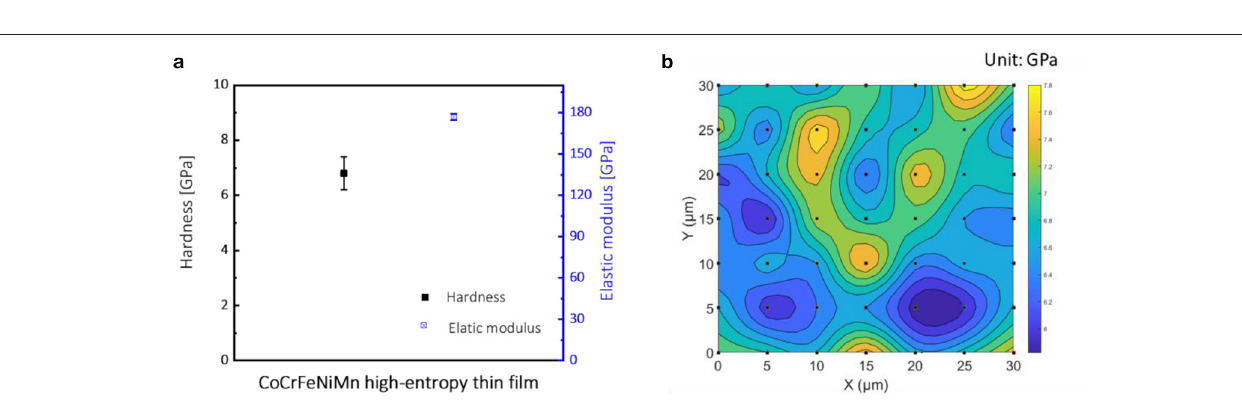
FIGURE 5 | Hardness, elastic modulus (a) , and hardness mapping (b) of the CoCrFeNiMn high-entropy thin